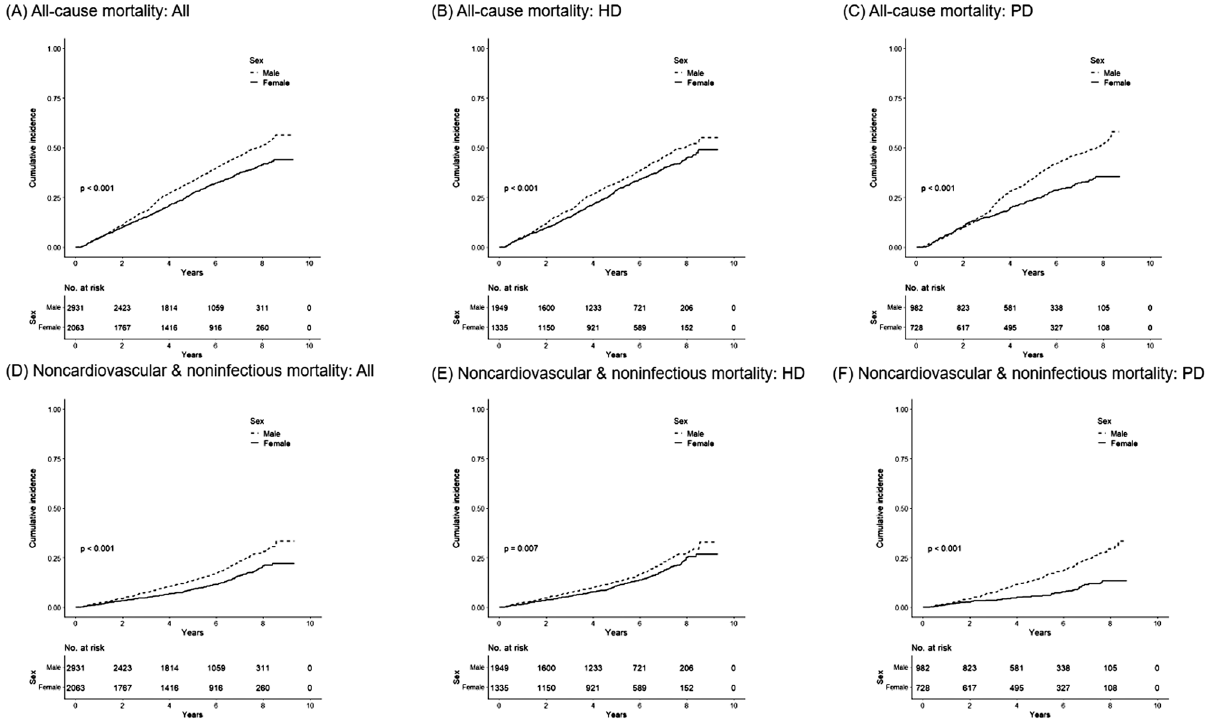
Figure 3. Cumulative incidence curve for deaths in male and female patients according to dialysis modality. ( A – C ) Male patients had significantly more all-cause death events and ( D – F ) noncardiovascular and noninfectious death events than female patients in the entire population, hemodialysis (HD) population, and peritoneal dialysis (PD) population.